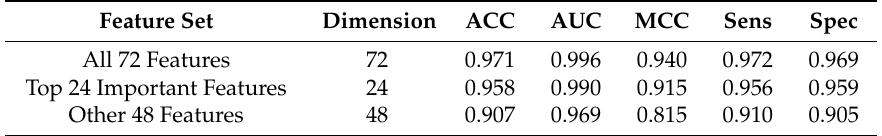
Table 4. Comparison of top 24 important features and remaining 48 features using independent testing on IT-set.